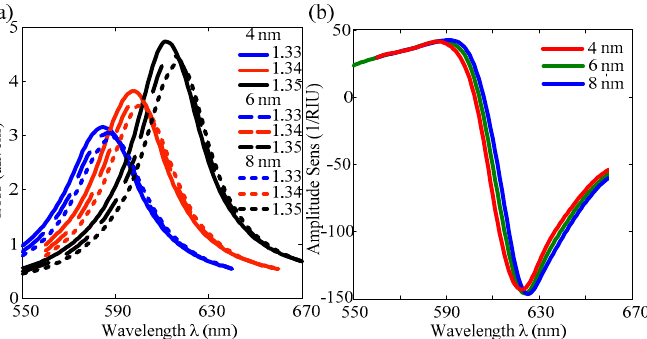
Figure 6. Effect of adhesive layer thickness: change in ( a ) loss spectra for analyte RI of 1.33, 1.34, and 1.35, and ( b ) amplitude sensitivity with the increase in TiO 2 layer for analyte RI = 1.34.